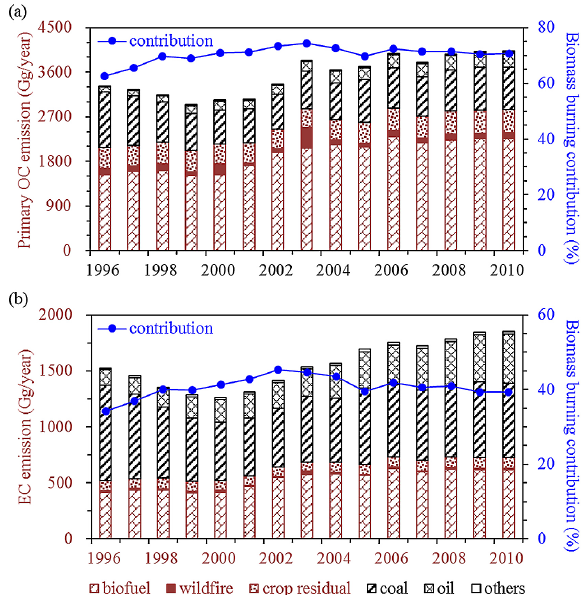
Fig. 1. Primary OC (a) and EC (b) emissions by fuel type in China during 1996 to 2010. The relative contributions of the total biomass burning sources are also shown. Data were obtained from Lu et al.